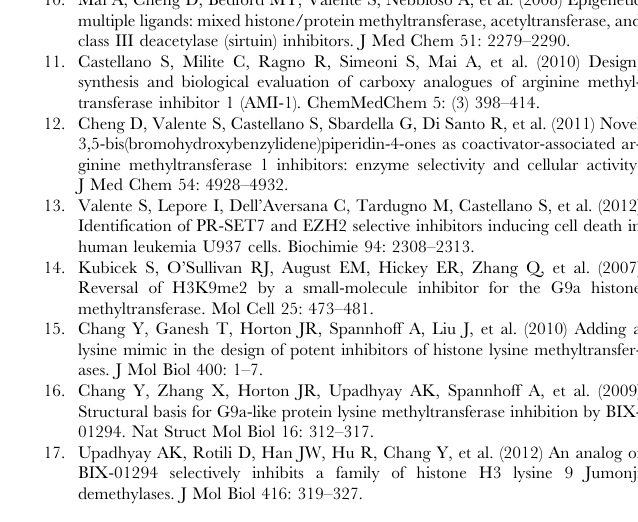
10 . GLP assay. Figure S1. Binding mode of 4 (yellow sticks) in the GLP binding site (green ribbons) as predicted by Glide. Figure S2. Predicted binding mode of 4 (a) and 14 (b) in the DNMT1 X-ray